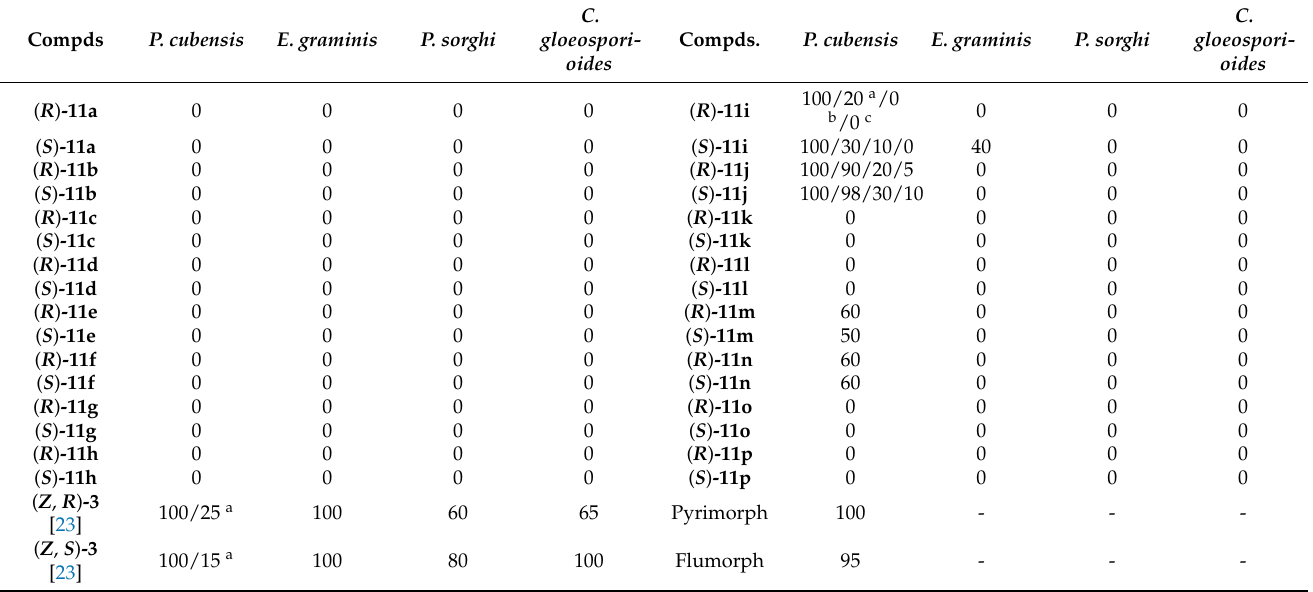
Table 3. The in vivo fungicidal activities of compounds 11a – 11p (efficacy%, 400 µ